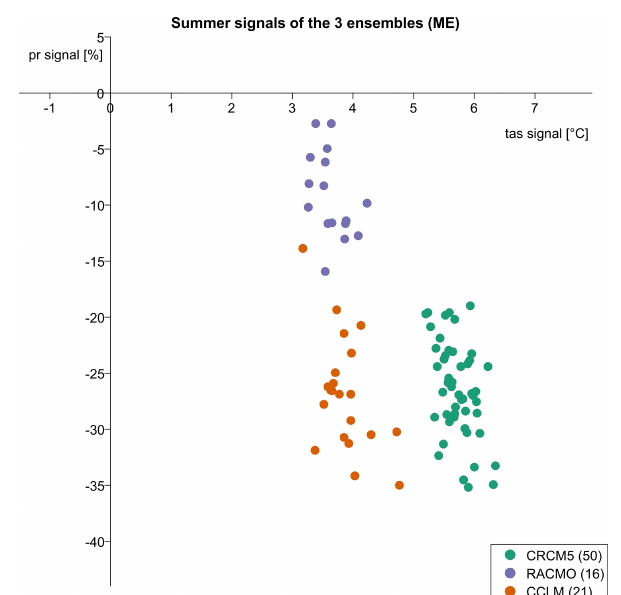
Figure 3. Change in winter temperature and precipitation for every member of the three ensembles in mid-Europe (2070–2099 against 1980–2009). Changes are relative to each members’ value in 1980– 2009 for precipitation, while temperature changes are